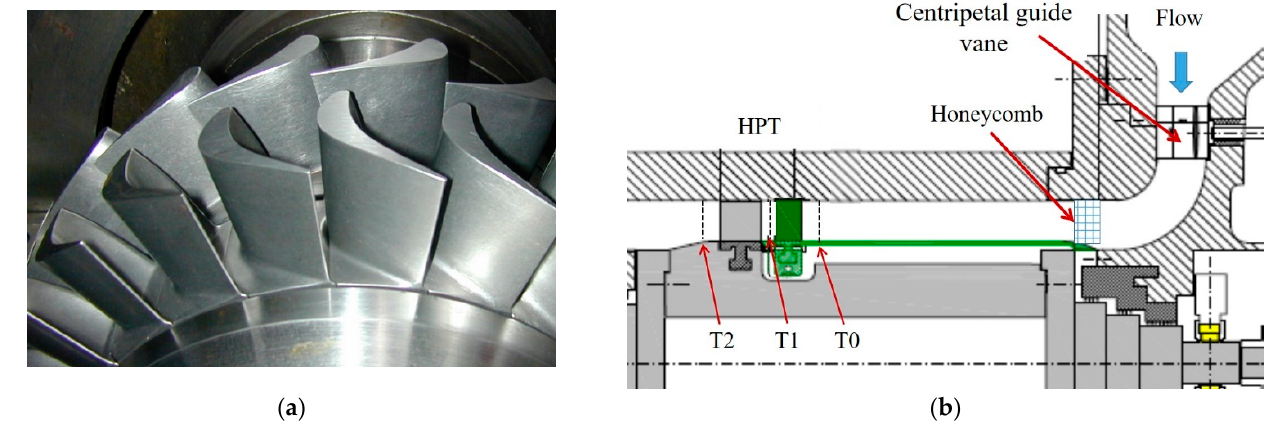
Figure 1. Picture of the turbine stage ( a ) and sketch of the meridional section ( b ).